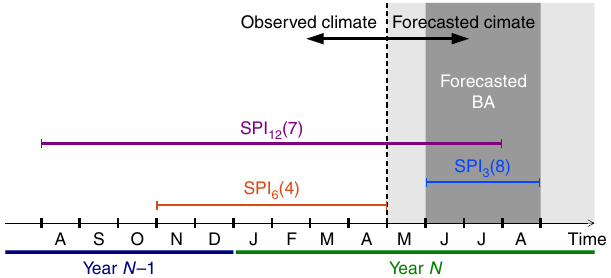
Fig. 1 Schematic view of the proposed burned area forecast system. In order to forecast burned area (BA) in JJA of year N (dark grey shadow), we rely on the climate forecast issued on May of the same year (dashed line). Before May, we have the observed climate data, while from May on (light grey) we only have seasonal climate forecasts. Observations and forecasts can be merged to construct the SPI t ( M − m ) − BA model, depending on the values of the parameters t (which can take a value of 3, 6 or 12 months) and M − m (which, in the illustrated example, can vary between March and August of year N , i.e. from the last month of the season being forecasted, back to the prior 6 months). As examples, we represent how climate observations and forecasts should be merged to compute SPI 12 (7) (purple line); how SPI 3 (8) is constructed from climate forecasts only (light blue line); and how SPI 6 (4) (orange line) is computed only from observations